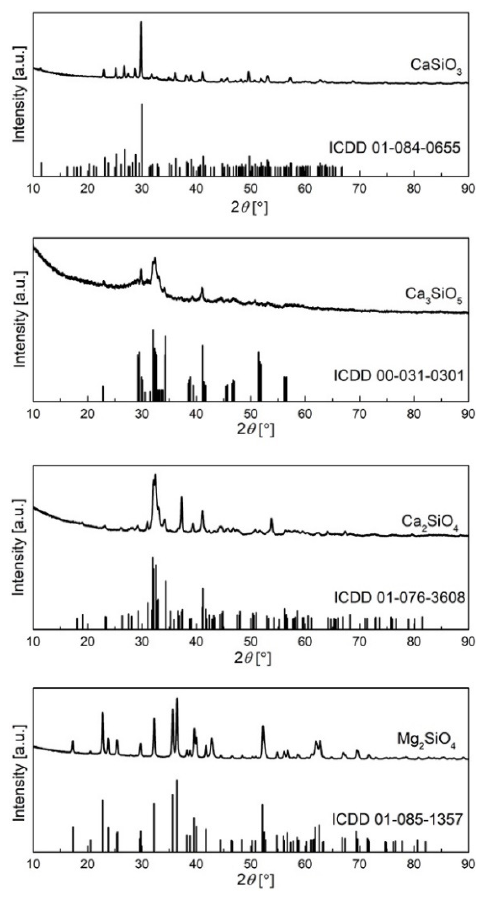
Figure 5. XRD spectra of the prepared silicates nanofiller.